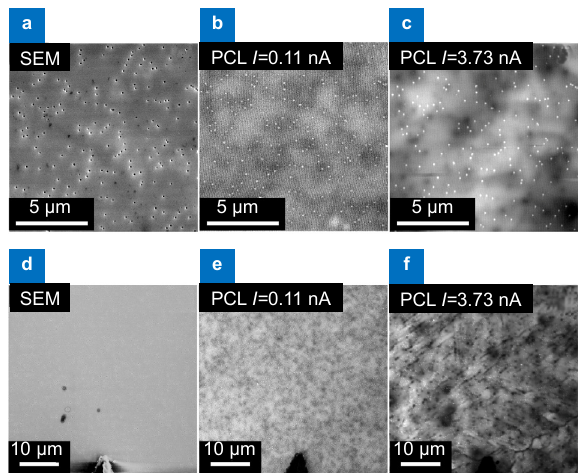
Fig. 2 | ( a ) SEM image of the GaN/InGaN multiple quantum well surface. ( b , c ) CL image of the same area of ( a ) at electron beam currents of 0.11 nA and 3.73 nA, respectively. ( d – f ) The same images at lower magnification clearly demonstrate the decline in luminous efficiency. Figure reproduced from ref. 56 , AIP